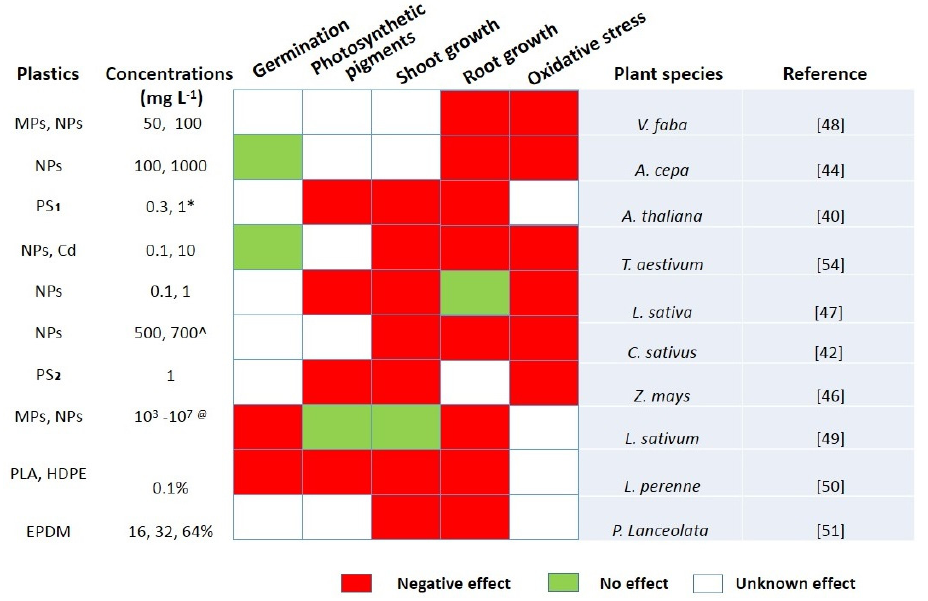
Figure 4. Effects of MPs and NPs on plant Physiology and biochemical indicators. PS 1 represents PS (SO 3 and NH 2 ), PS 2 represents (COOH and NH 2 ), * represents g Kg − 1 , ^ represents nm, and @ represents particles L − 1 .